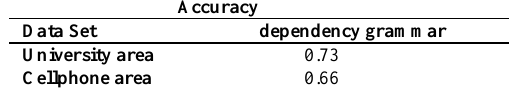
Table 7. Accuracy for extracted opinion words' polarity.